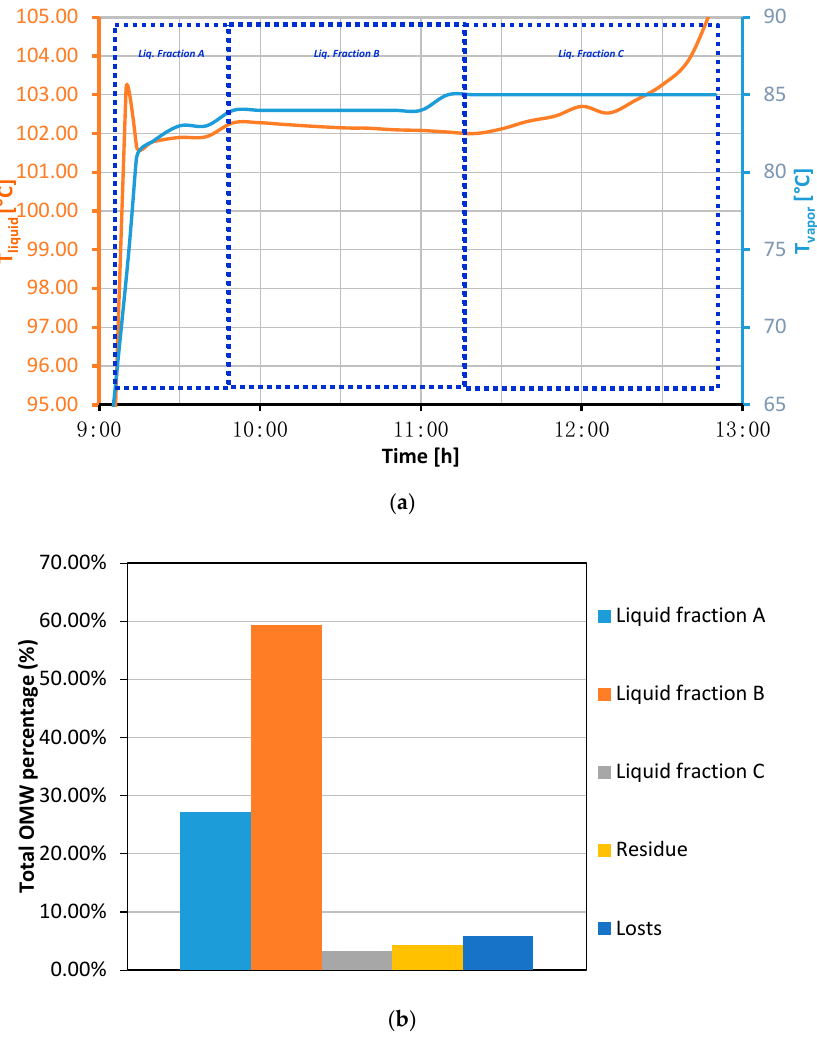
Figure 3. ( a ) Distillation curve of real olive mill wastewater (OMW) and ( b ) distilled mass fraction distribution.